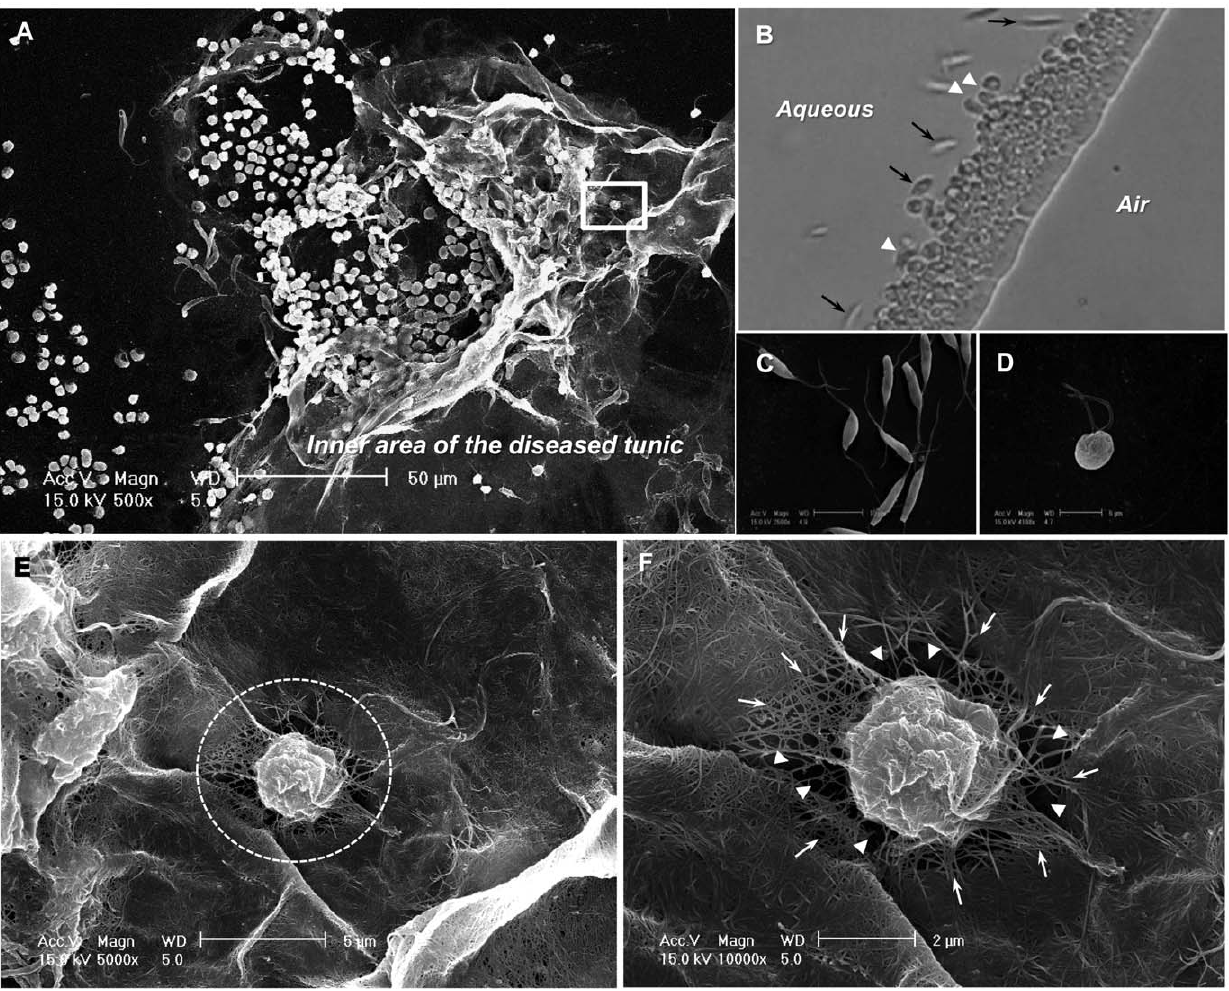
Figure 2. FE-SEM observation of the peri-epidermal area of diseased tunics. (A) FE-SEM image showing flagellate-like cells, cyst-like cells formed from flagellates, and their distributions along the diseased tunic. (B) Inverted fluorescence microscopy of the released flagellates from disease tunics shows flagellates clustered together and aligned at the aqueous (left side)–air (right side) interface. Also shown is their migration around a cyst (black arrow) and morphological changes (white arrowhead). (C) The pathogenic flagellate has a fusiform body , 10–13 m m in length, and two flagellae. (D) During the formation of a spherical or ovoid-shaped cyst (3–4 m m in diameter), cells round up and the flagellae lie closed against the body. (E) An enlarged view of the square in A, the thinner tunic fibers and coarse tunic matrix associated with cyst-like structures are shown inside the dotted circle. (F) An enlarged view of E, in which arrowheads indicate empty spaces and arrows show the tunic fibers. Scale bars: (A) 50 m m, (C) 10 m m, (D) 5 m m, (E) 5 m m, and (F) 2 m m.